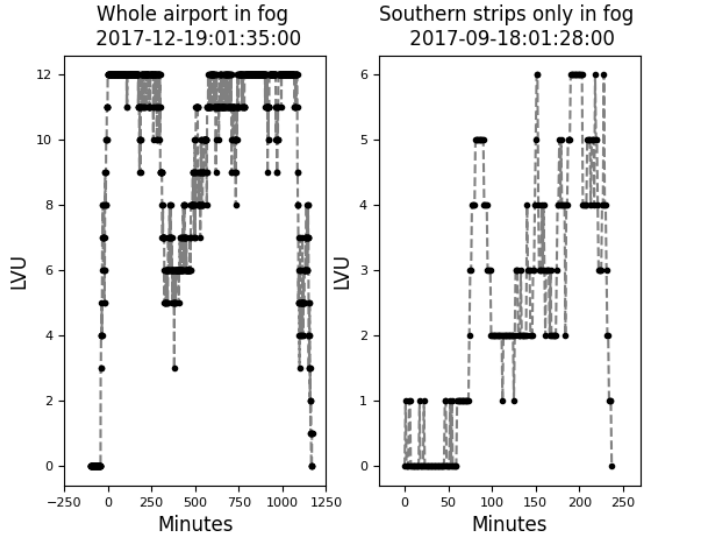
Figure 2. Two examples of LVU sequences: fog enveloped the entire airport, i.e, LVU = 12 ( left panel, 2017-12-19 01:35 UTC to 2017-12-19 21:46 UTC) and fog covering the southern part of the aiport only, i.e., LVU = 6 ( right panel, 2017-09-18 01:28 UTC to 2017-09-18 04:25 UTC) The x-axes correspond to minutes since the beginning of